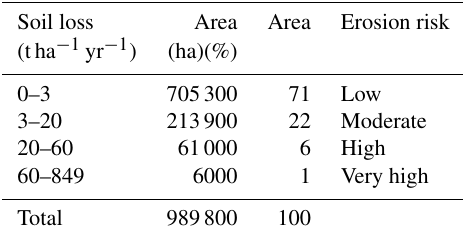
Table 1. Distribution of soil losses in the Bouregreg